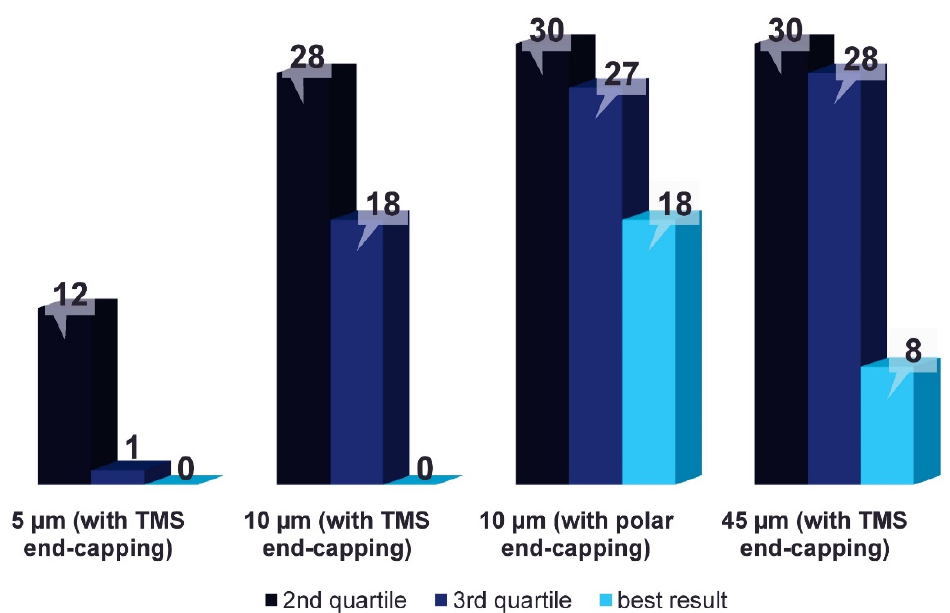
Figure 1. Number of results above the median (2nd quartile), in the 3rd quartile, and the number of best results recorded for the most effective coating–desorption solvent combinations for each coating type. Results for 5 µ m particles after desorption to DS1b comprised isopropanol/water/ammonium hydroxide (80/19.9/0.1, v / v ) are shown; results for the other particles after desorption to DS3a comprised methanol/water/formic acid (80/19.9/0.1, v / v ) are shown.